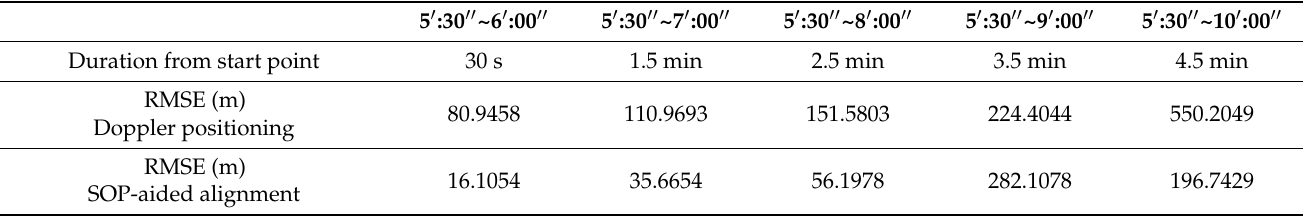
( b ) Figure 17. ( a ) Estimated accelerometer bias, and ( b ) Estimated gyroscope bias with ±3𝜎 bound.